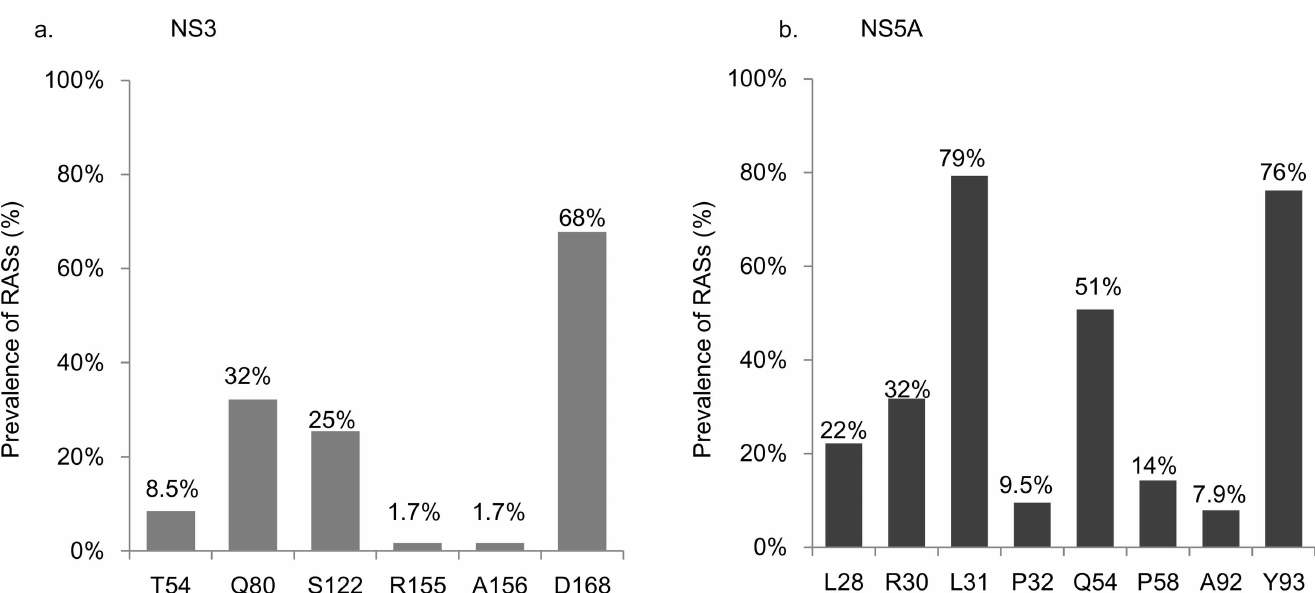
Fig 1. Prevalenceof RASs after failure of combination therapy with daclatasvir and asunaprevir. Prevalence of RAS in NS3 (a) and NS5A(b).